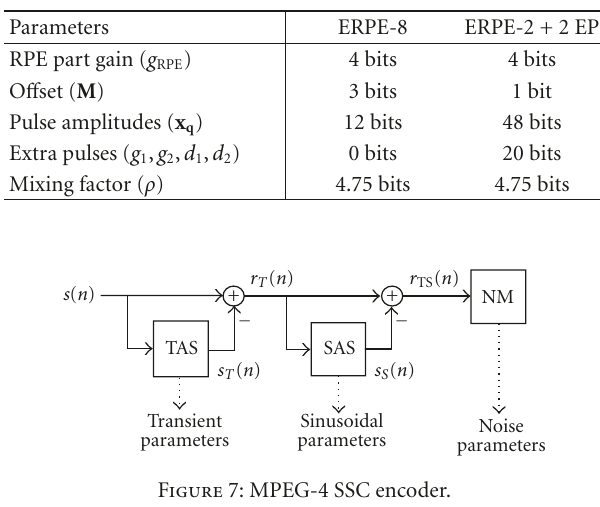
Table 1: Bit rate for the di ff erent parameters of ERPE models for a